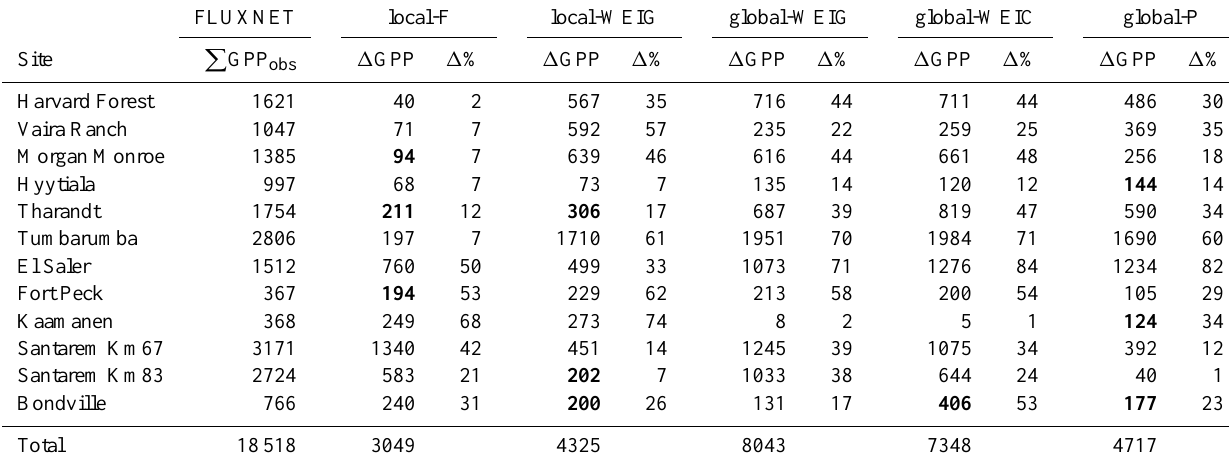
Figure 2. Comparison of modelled and observed GPP using bias and RMSE at the 12 FLUXNET sites (HF: Harvard Forest; VA: Vaira Ranch; MM: Morgan Monroe; HY: Hyytiala; TH: Tharandt; TUM: Tumbarumba; ES: El Saler; FP: Fort Peck; KA: Kaamanen; S67: Santarem Km67; S83: Santarem Km83; BO: Bondville) for three sets of model simulations: (a) local-F; (b) global-WEIG; and (f) local-WEIG (Table 3). (c) displays the differences between bias and RMSE for global-WEIG and local-F model simulations; (d) differences between local-WEIG and local-F model simulations; and (e) differences between global-WEIG and local-WEIG model simulations. Marked on (c) , (d) and (e) next to the figure letter are how the sets of model simulations differ. The site labels are coloured according to their climate zone (Table 2). The dashed lines on (a) show the regions defined by the qualitative terms (Table 4) used to describe model performance. Table 7. Absolute and percentage differences between model simulated and observed (FLUXNET) total annual GPP (gCm − 2 year − 1 ) at the 12 flux tower sites. P GPP obs is the observed total annual GPP, (cid:49) GPP is the absolute difference (Eq. 3) between the model and observed total annual GPP, and (cid:49) % is the percentage difference (Eq. 4) between the model and observed total annual GPP. Values highlighted in bold mean that the difference is negative (i.e. P GPP obs < P GPP model ). The total value for each of the model simulations was computed using the differences and not the absolute